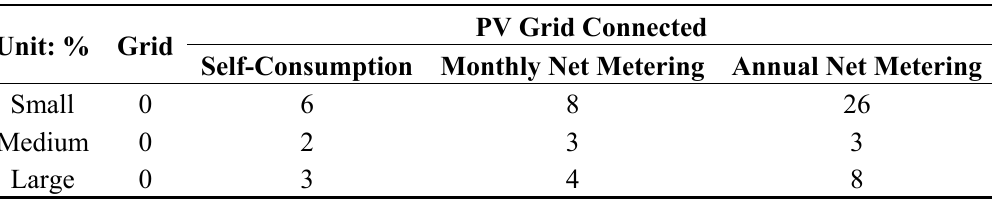
Table 9. Renewable percentage.